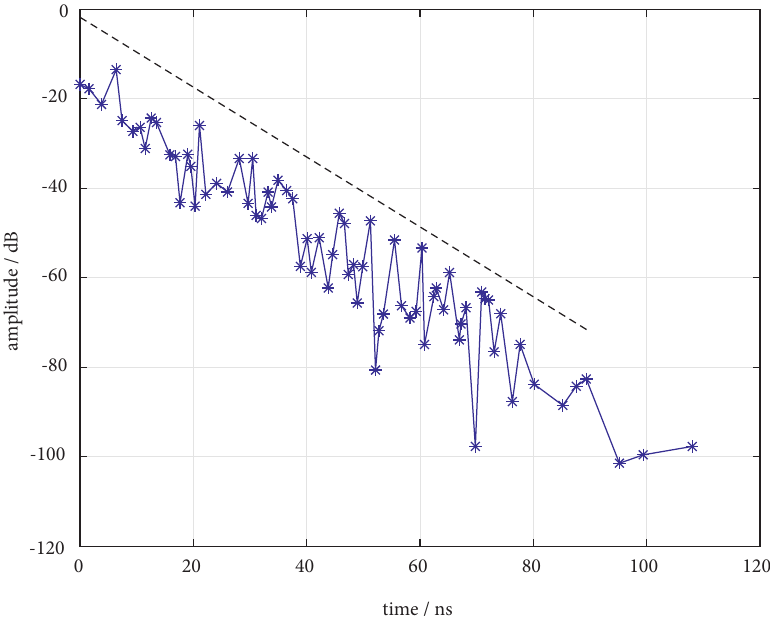
Figure 9: Clustering power delay spectrum at different positions.